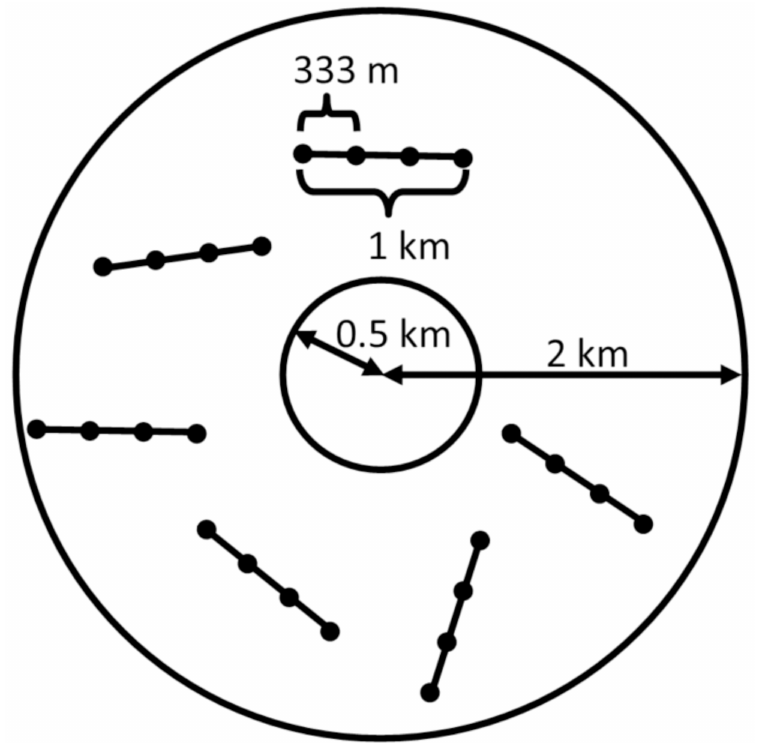
Fig 2. Example of the arrangement of sample points and transectswithin each survey site used to sample sciurid and leporid prey species in Wyoming, USA.